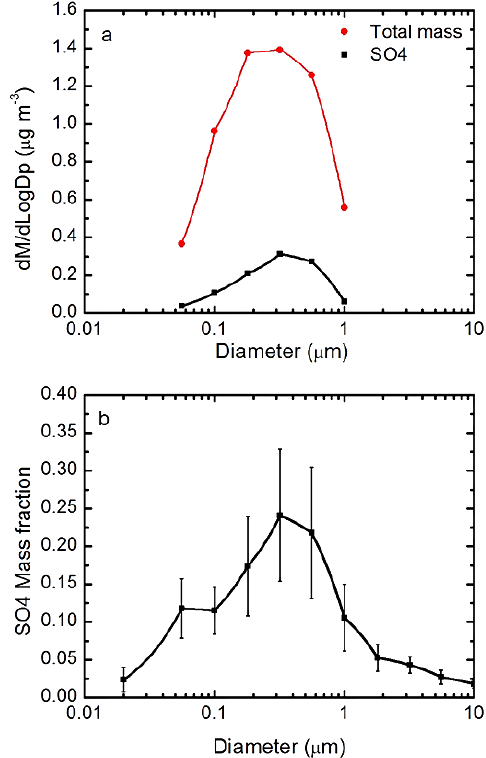
Figure 5. Comparison of modelled and measured CCN concentra- tions using internal mixing for the five estimated supersaturations (0.23, 0.45, 0.68, 0.90, and 1.13%).